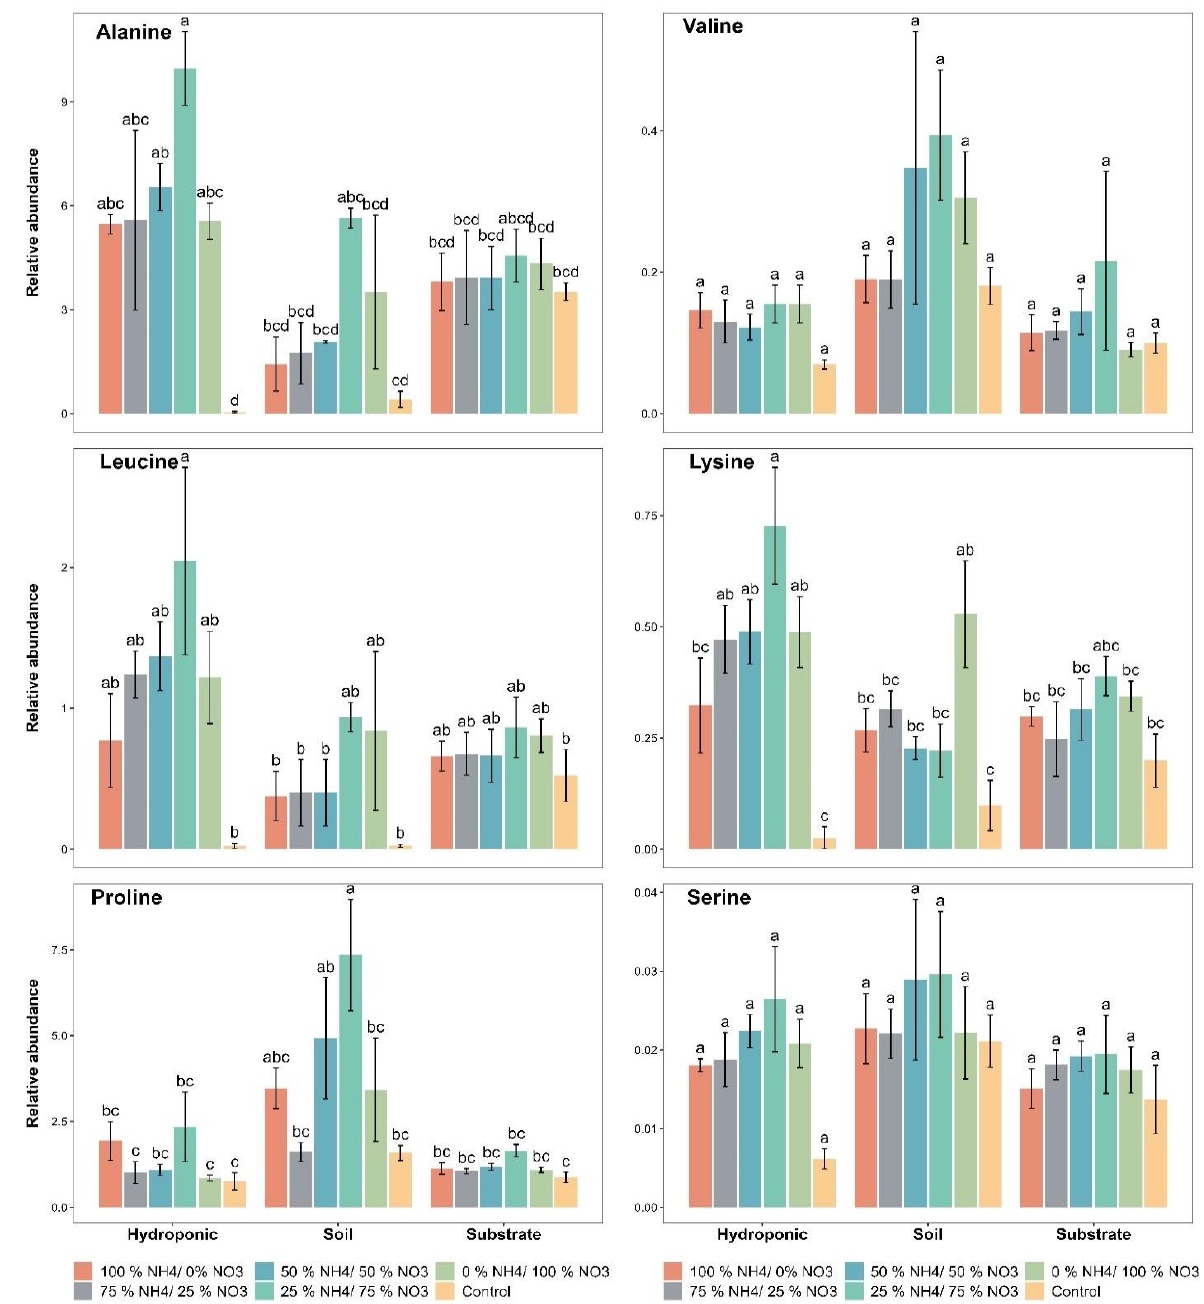
Figure 5. Effect of various applied NH 4+ /NO 3 − ratios (100:0, 75:25, 50:50, 25:75 and 0:100%) and control (no additional N applied) on different amino acid contents of lettuce grown in soil, substrate and hydroponic cultivation systems. Note- The means ( n = 4) ± standard errors are shown in the data. Different letters (a–d) show significant difference ( p = 0.02) among applied NH 4+ /NO 3 − ratios (100:0, 75:25, 50:50, 25:75 and 0:100%) and control in lettuce grown in soil, substrate and hydroponic cultivation systems